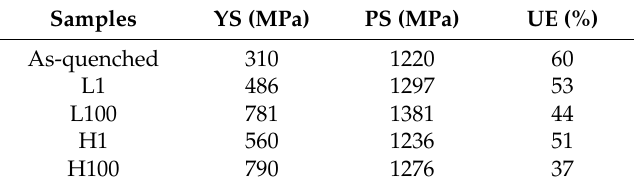
Table 2. Yield strength (YS), peak strength (PS), and uniform elongation (UE) of various samples.